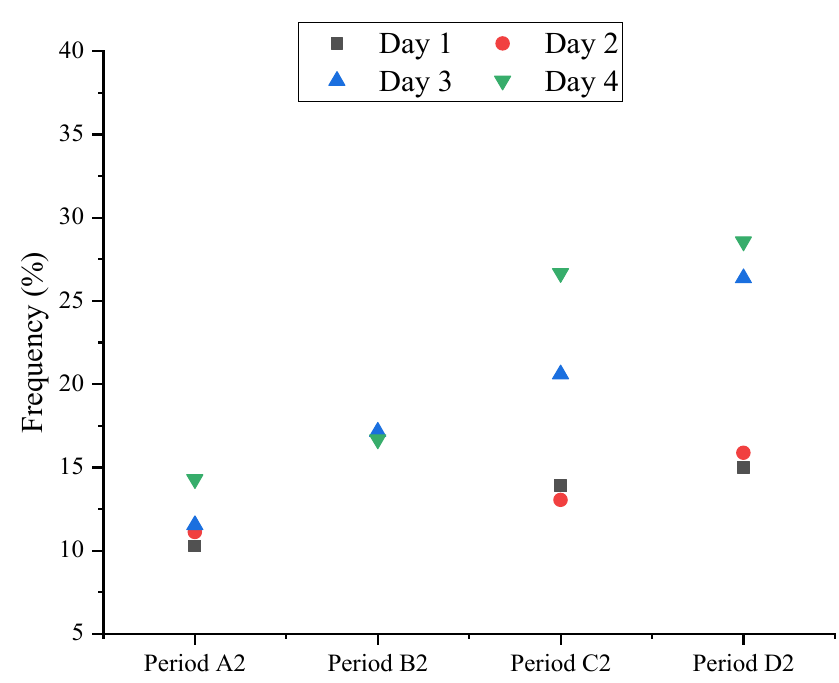
Figure 14. Total frequency of adding and reducing in different periods.